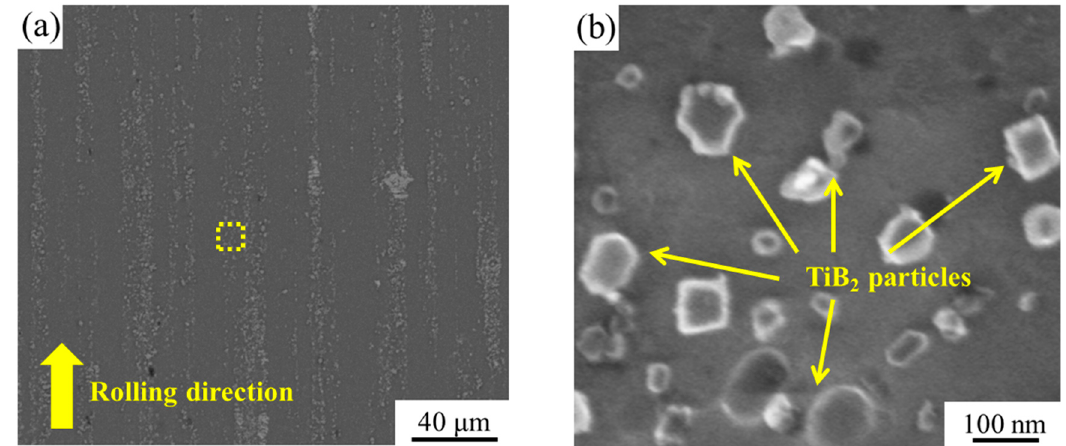
Figure 2. SEM (backscattered electron) micrographs of an in situ TiB 2 /2024 composite ( a ) low magnification image along the rolling direction and ( b ) corresponding high magnification image of the zone boxed in ( a ).